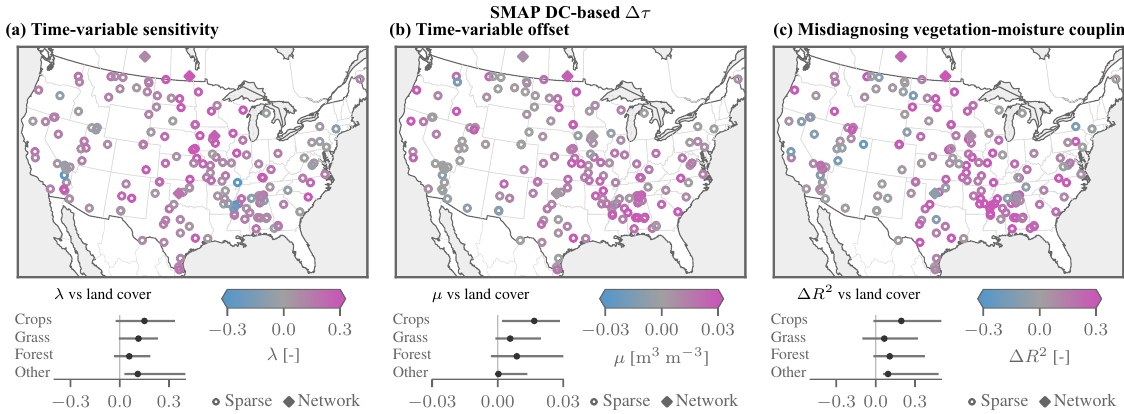
Figure 8. Time-variable biases and (cid:49)R 2 coupling metric across the contiguous US, obtained using the SMAP DC τ product. Cf. Fig. 7 for results based on the SMOS τ product.